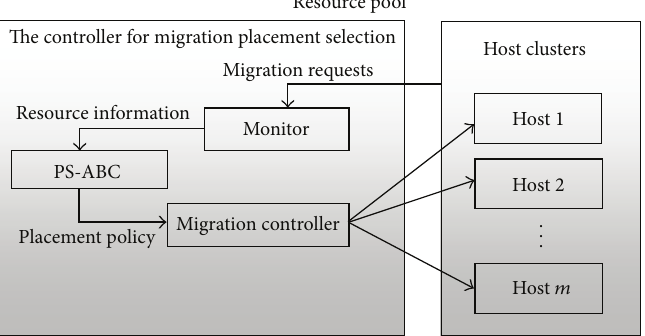
Figure 1: The view of PS-ABC’s